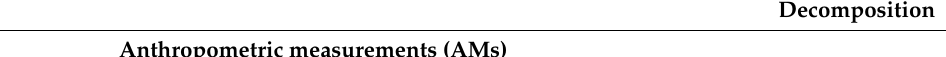
Table 1. Biomechanical measurements. Abbreviations: AP, anteroposterior; C7, seventh cervical vertebra; CoM, center of mass; CoP, center of pressure; ML, mediolateral; PSIS, posterior superior iliac